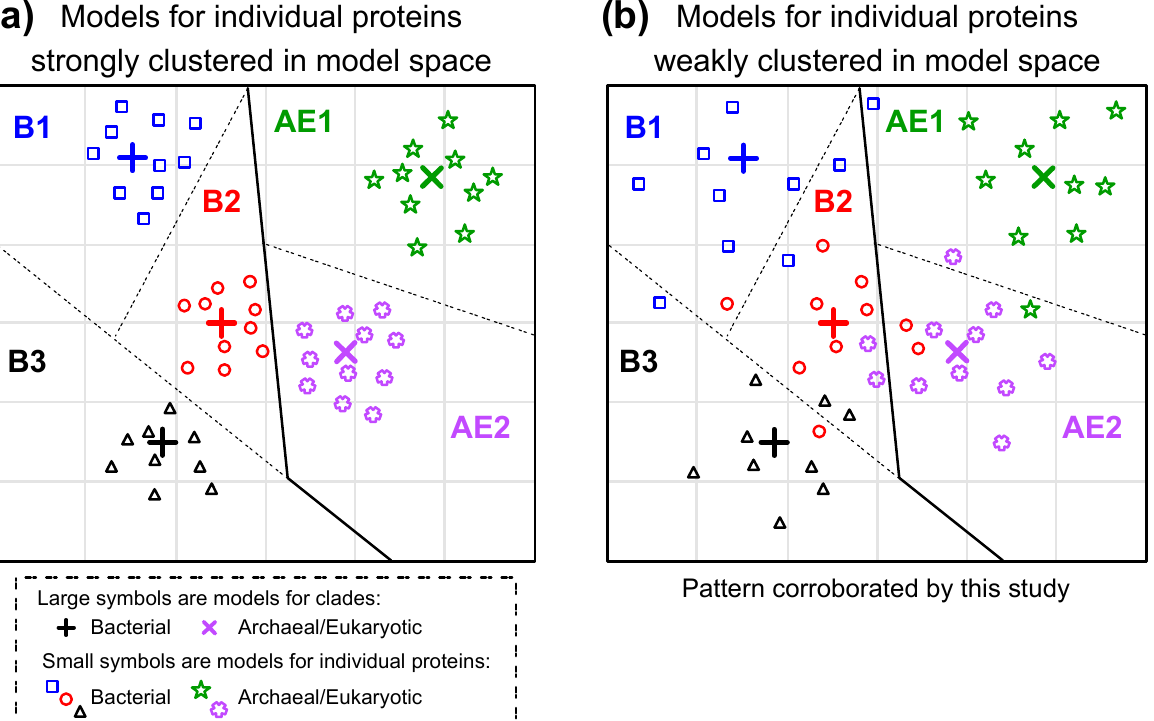
Figure 5. Potential patterns for variation among proteins and among clades in their underlying models of protein sequence evolution. Models for individual proteins are presented as either ( a ) strongly clustered or ( b ) weakly clustered. This conceptual illustration presents a two-dimensional model space. This was done to facilitate visualization; the actual model space defined by R matrices fore time-reversible 20 × 20 rate matrices has 190 dimensions. We only present five clades and ten proteins per clade to further simplify visualization. We divided model space into regions where the best-fitting model is the clade-specific model, with lines representing the boundaries of those regions (dotted lines divide regions within bacteria or archaea + eukaryotes; solid lines divide bacteria from archaea + eukaryotes). The results of this study support weak clustering in model space. In fact, the poor performance of models as classifiers (Table 1) suggests that models for individual proteins are very dispersed; we have limited the dispersal in this illustration to facilitate visualization.